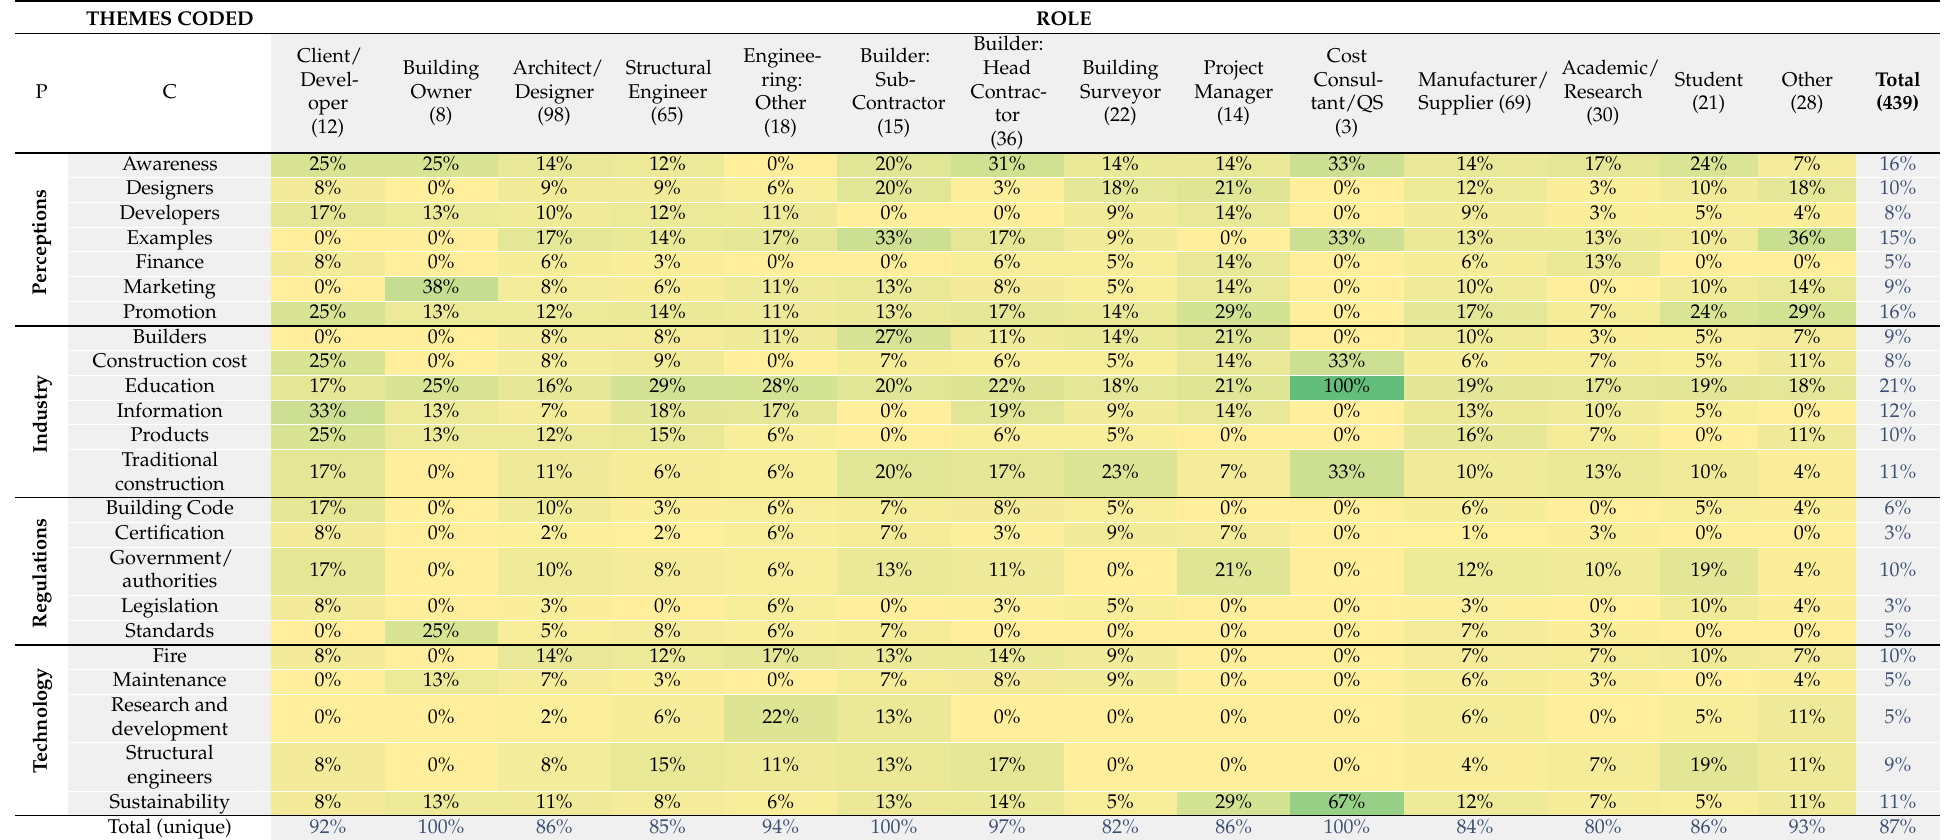
Table A3. Heat map of themes identified as critical for adoption, filtered by industry